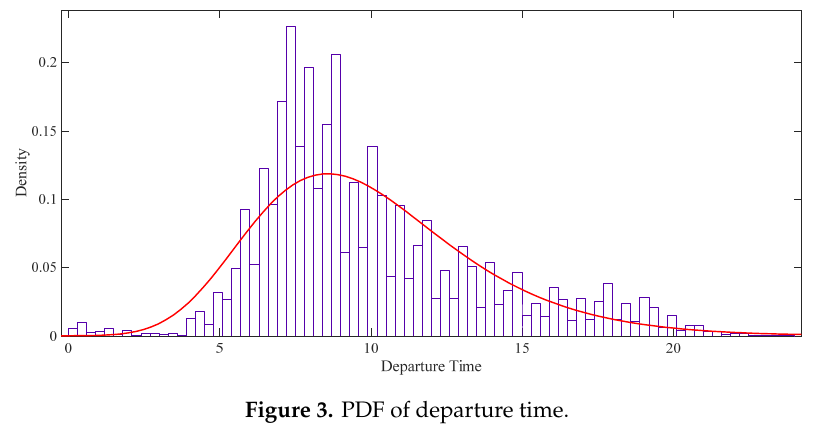
Figure 3. PDF of departure time. Appl. Sci. 2019 , 9 , x FOR PEER REVIEW Figure 3. PDF of departure time. Figure 3. PDF of departure time.